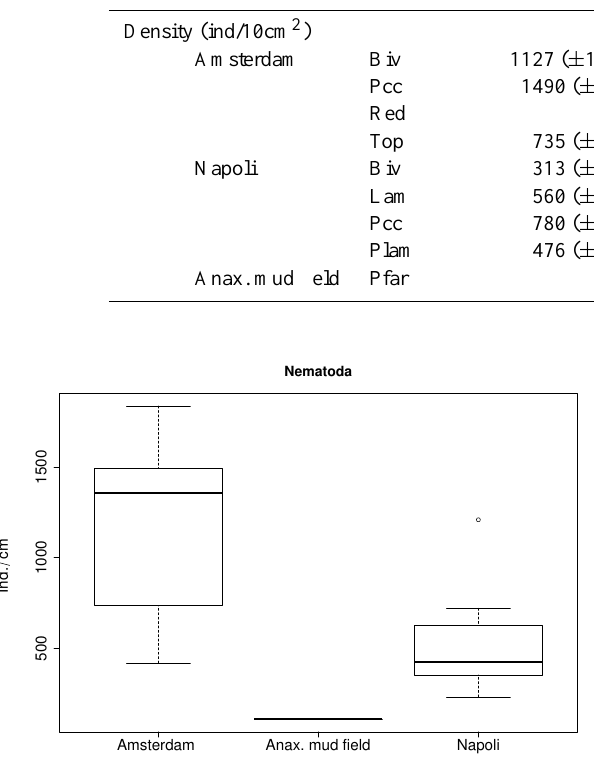
Fig. 3. Box-plot showing differences in nematode densities between the Amsterdam and Napoli mud volcanoes and the far periphery site (Anaximander mud